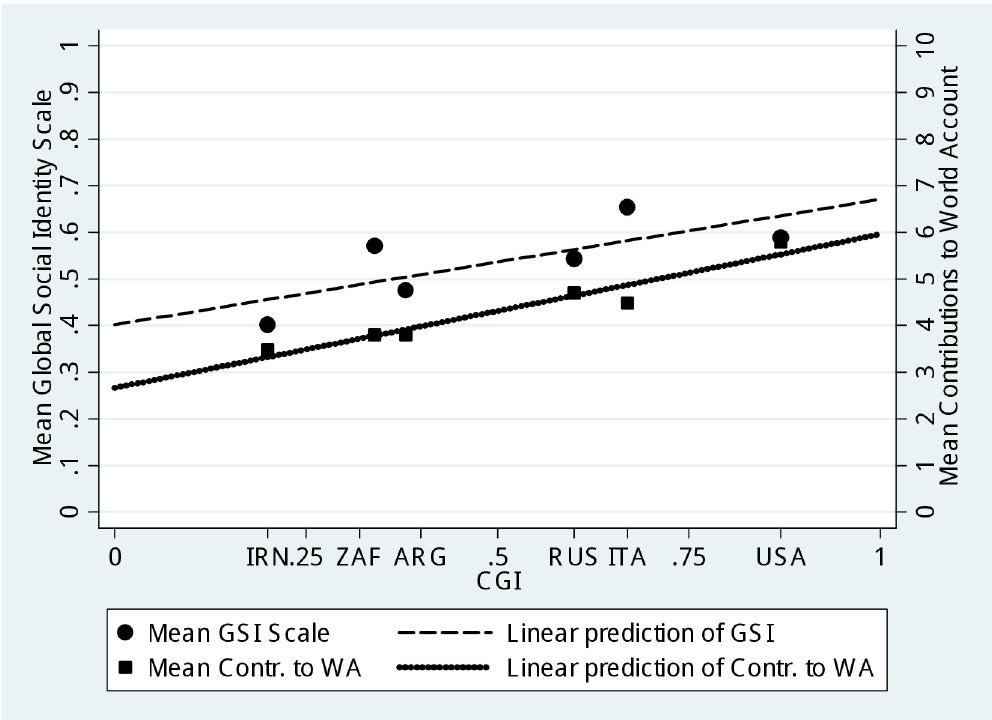
Fig 4. Correlation between country-level globalization index, global social identity scale, and world-level cooperation. The chart reports country-level mean values for the GSI index (circles), and the contribution to world account (WA) (squares), as well as the linear predictions of GCI onto GSI and contributions to WA (dashed and solid lines, respectively).